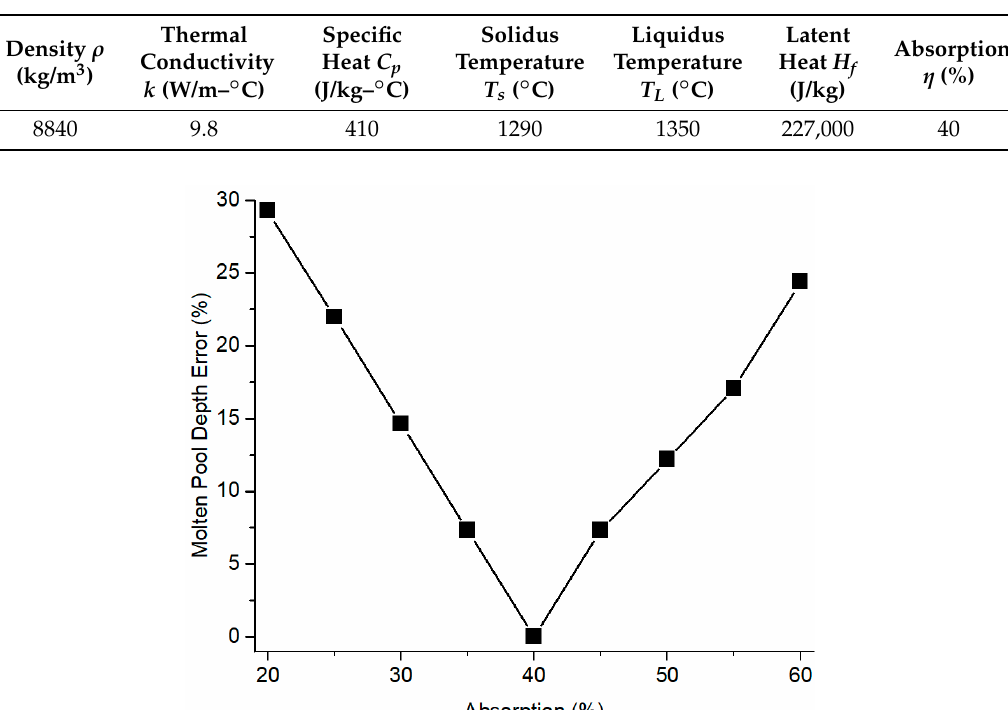
Table 2. Material properties of Inconel 625 and inversely determined laser absorption ( (cid:1846) (cid:2868) = 20 °C ) [14,27].